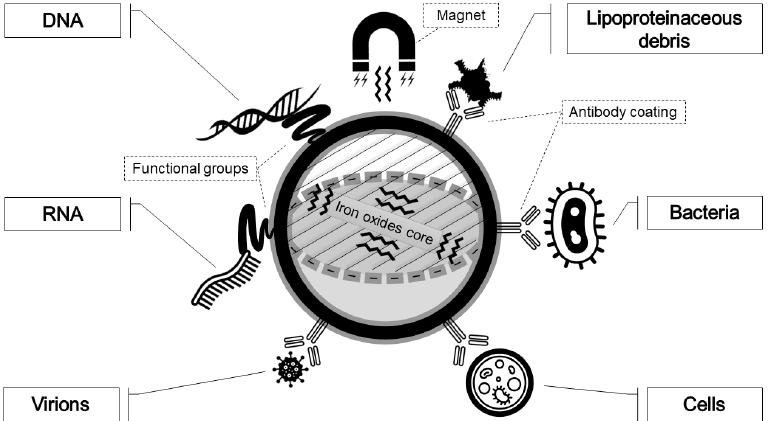
Figure 6. Magnetic beads can be magnetically manipulated because of their iron core and — with their activated coatings, such as functional groups or specific antibodies — can interact and selec- tively bind a desired ligand. The most recurrent functionalization for NA extraction is the silica-